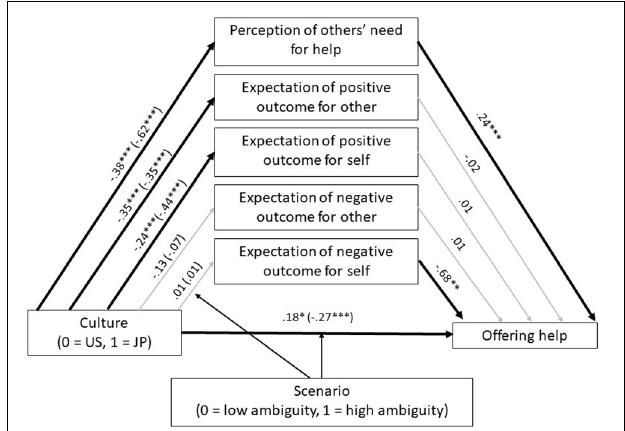
FIGURE 3 | Perceived need for help and expectations of outcomes for others and self accounting for the cultural difference in offering help to a stranger in low and high ambiguity situations (Study 3). Values are unstandardized coefficients. Values in parentheses are for high ambiguity scenarios. Arrows in bold indicate paths that were significantly moderated by scenario. ∗ p < 0.05, ∗∗ p < 0.01, ∗∗∗ p <